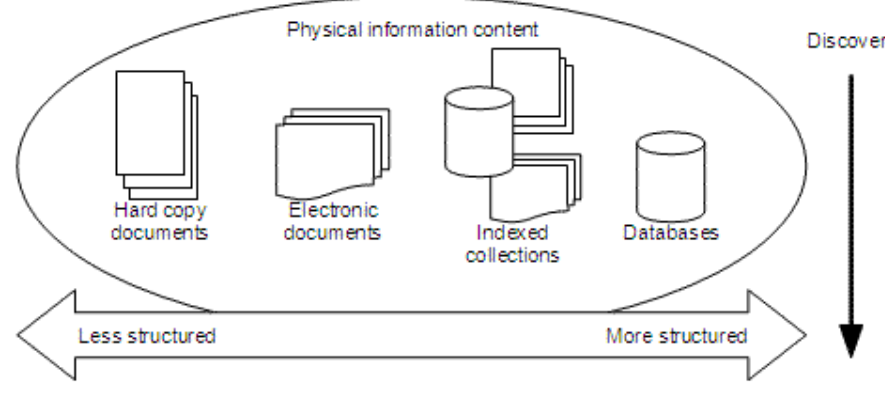
Figure 1 Discovery step (adapted from Fisher